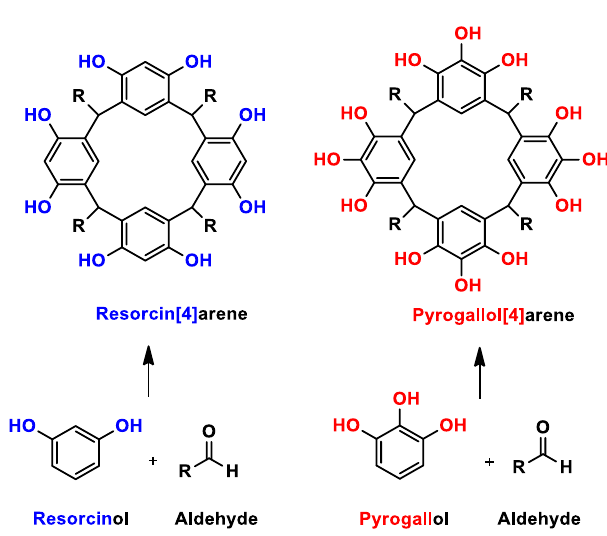
Scheme 1. Synthesis of resorcinarenes and